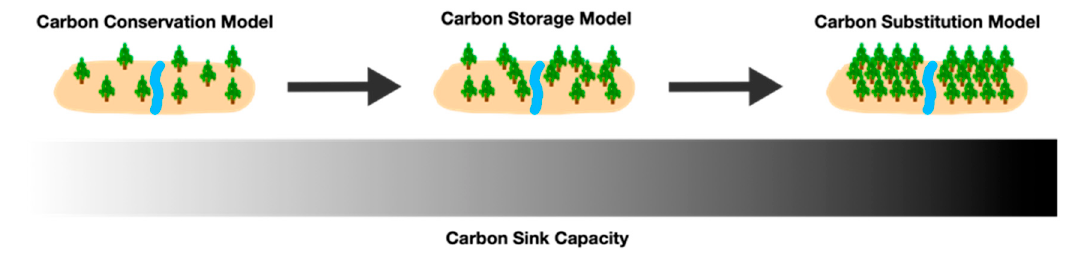
Figure 7. Models of forest management based on carbon flows.